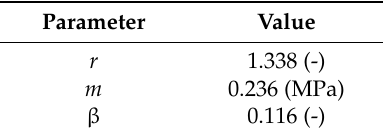
Table 4. Damage model parameter values fitted from experimental